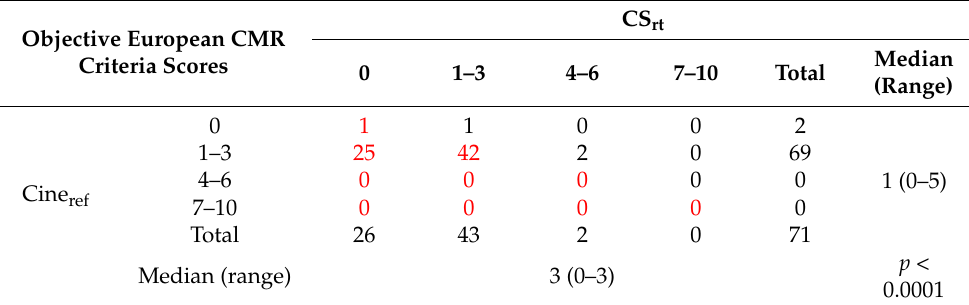
Table 5. Objective image quality with EuroCMR criteria scores: comparison between Cine ref and CS rt image